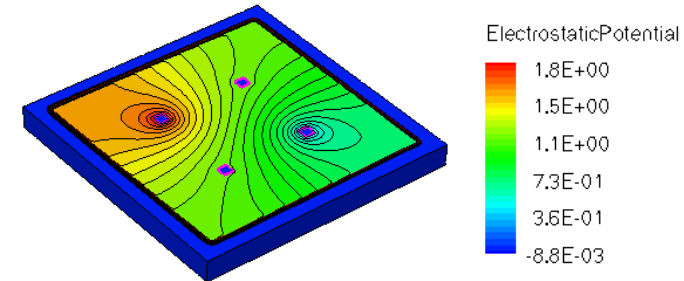
Figure 11. Electrostatic potential (V) for borderless structure, B = 0.5